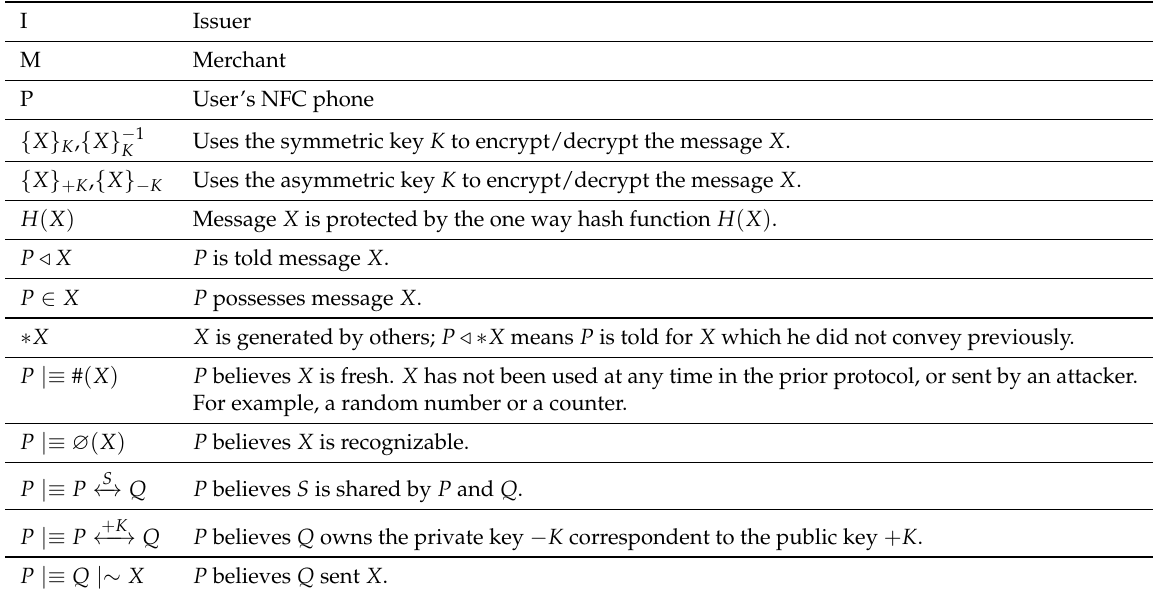
Table 3. Notations of the GNY